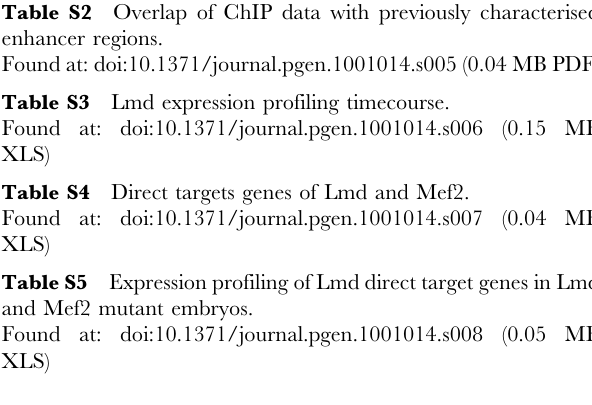
Figure S3 Enhancer activity in lmd and Mef2 loss-of-function mutant embryos. In situ hybridisations described in Figure 4 were performed by double-staining of GFP (green, first and third column, indicating specific reporter activity) and either endoge- nous twist mRNA (red, in lmd mutants) or lacZ mRNA expressed from a balancer (red, in Mef2 mutants) to identify homozygous mutant embryos. Twist expression persists longer in lmd mutants (C 9 . G 9 , K 9 , O 9 , S 9 , W 9 ) than in wt embryos (A 9 , E 9 , I 9 , M 9 , Q 9 , U 9 ). LacZ expression is associated only with heterozygous, balancer containing embryos (B 9 , F 9 , J 9 , N 9 , R 9 , T 9 , X 9 ) (or embryos carrying two balancers). Table S1 ChIP-on-chip enriched fragments.